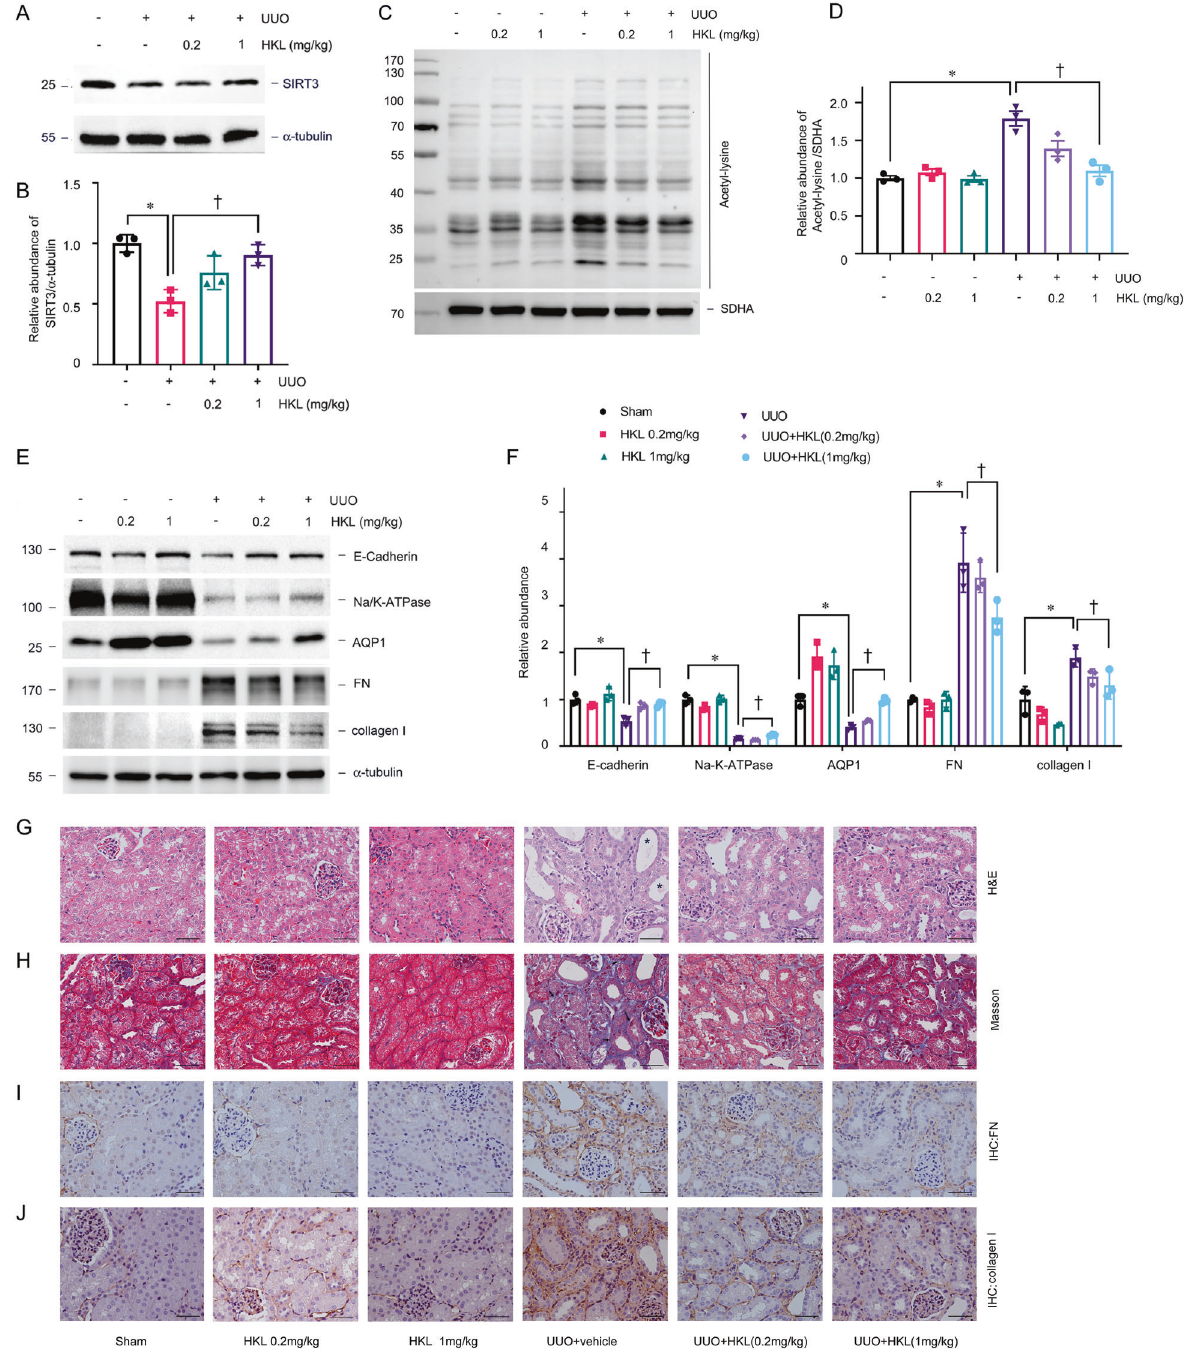
Fig. 2 Honokiol reduces mitochondrial acetylation and renal fi brosis. A , B : Amount of SIRT3 protein in kidney tissues from UUO mice injected with or without honokiol (HKL). α -tubulin served as the standard (* P < 0.05, † P < 0.05; n = 3). C , D Western blots of acetyl-lysine in tubular mitochondrial lysates from UUO mice injected with or without HKL on POD 1. SDHA served as the standard (* P < 0.05, † P < 0.05; n = 3). E , F Western blots of E-cadherin, Na/K-ATPase, AQP1, FN, and collagen I in UUO mice injected with or without HKL on POD 7. α -tubulin served as the standard (* P < 0.05, † P < 0.05; n = 3). G – J Representative images of H&E ( G ) (Star indicated tubular atrophy), Masson ( H ) (Arrow indicated collagen deposition), and immunohistochemical staining for FN ( I ) and collagen I ( J ) in kidneys on POD 7 after UUO in mice injected with honokiol. The bar indicates 50 μ